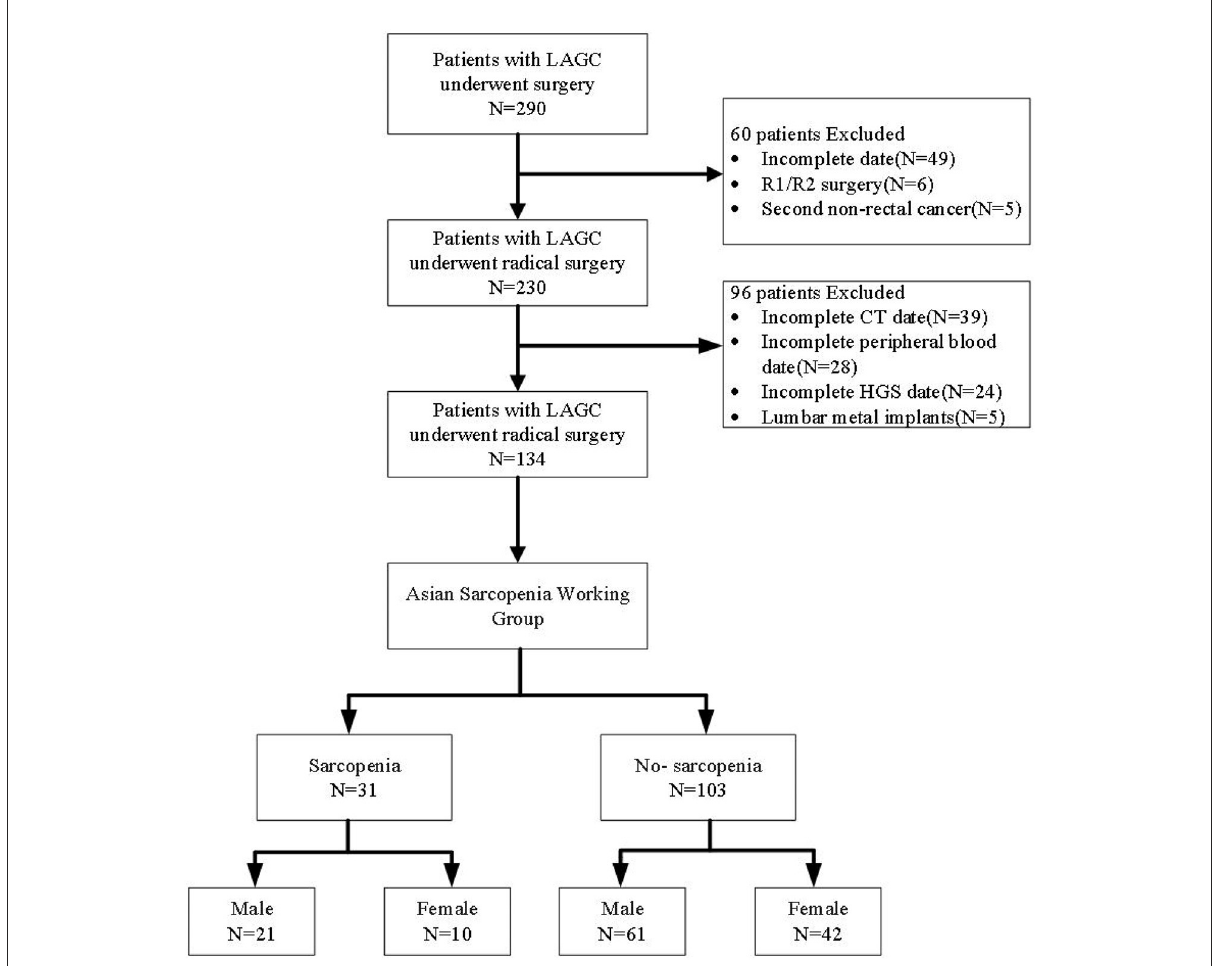
FIGURE1 Flow diagram participants included in the study. LAGC, locally advanced gastric cancer; HGS, handgrip